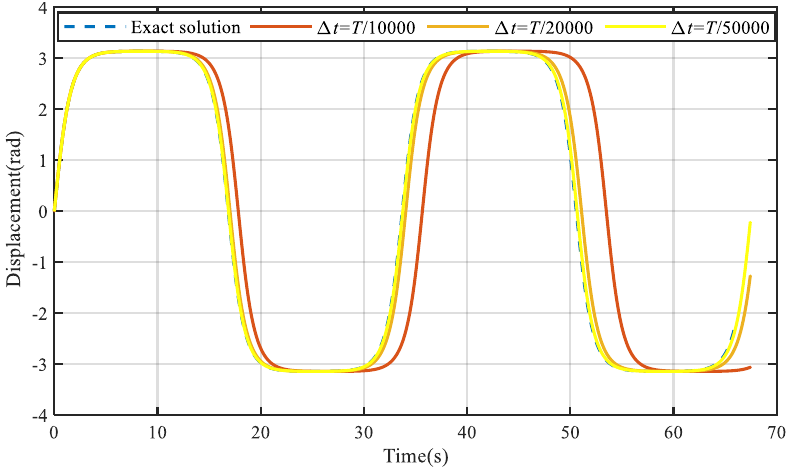
Figure 10. Results of the proposed method with different time steps Δ t = T /10000, T /20000, T /50000.